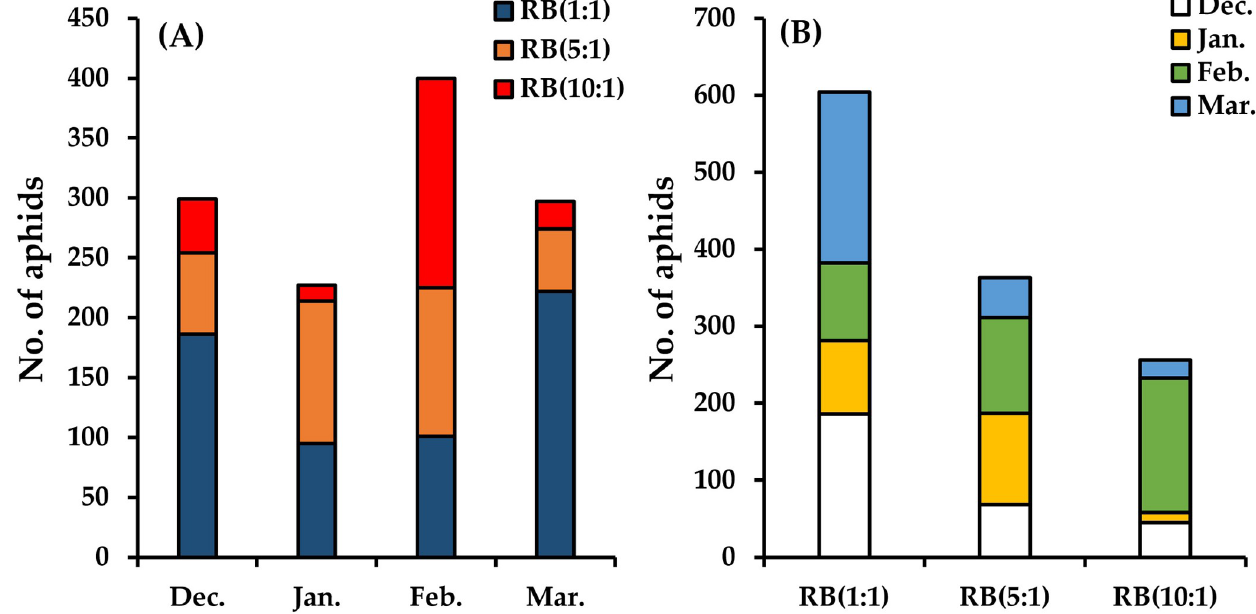
Fig 2. The number of aphids on the leaves of Eutrema japonicum monthly (A) and according to red:blue (RB) mixed light irradiation ratios of 1:1, 5:1 and 10:1 (B).